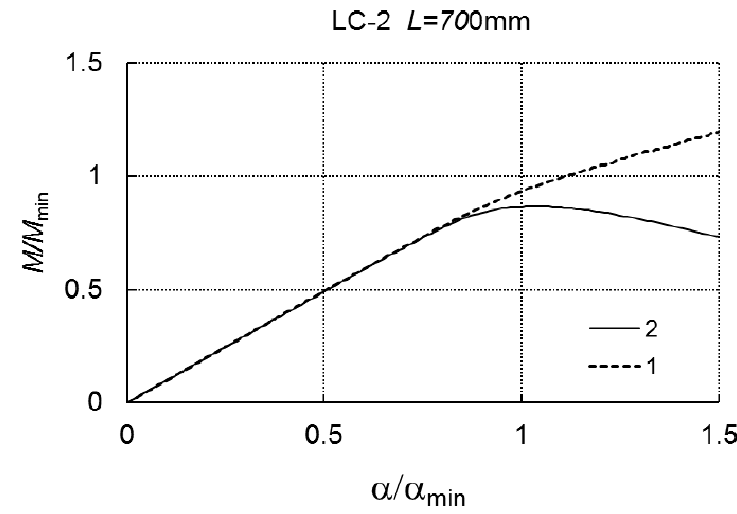
Figure 10. M / M min versus α / α min for LC-2 and L = 700 mm. Figure 10 . M/M m in versus α / α min for LC-2 and L = 700 mm.